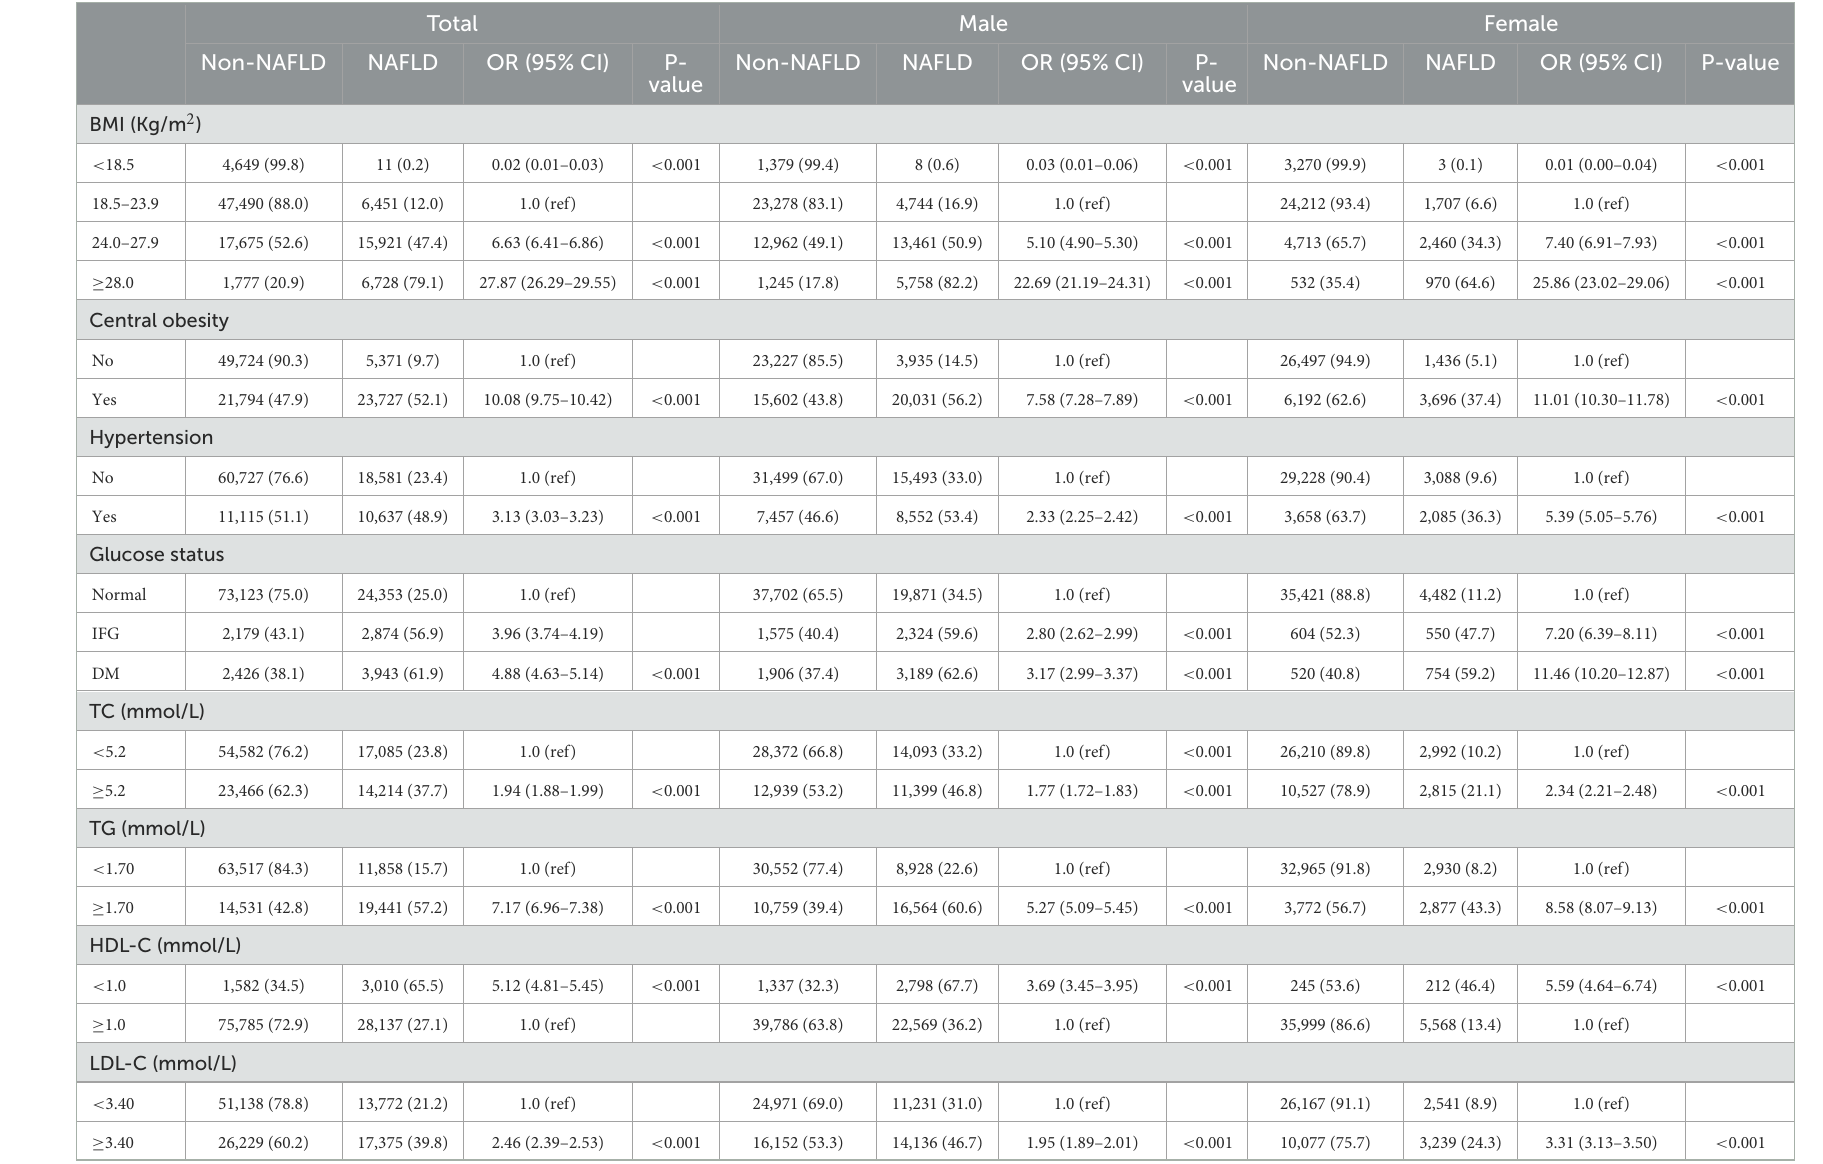
TABLE 2 Association between risk factors and NAFLD analyzed by univariable binary logistic regression ( N = 110,626). Total Male Female Non-NAFLD NAFLD OR (95% CI) P- Non-NAFLD NAFLD OR (95% CI) P- Non-NAFLD NAFLD OR (95% CI) value value